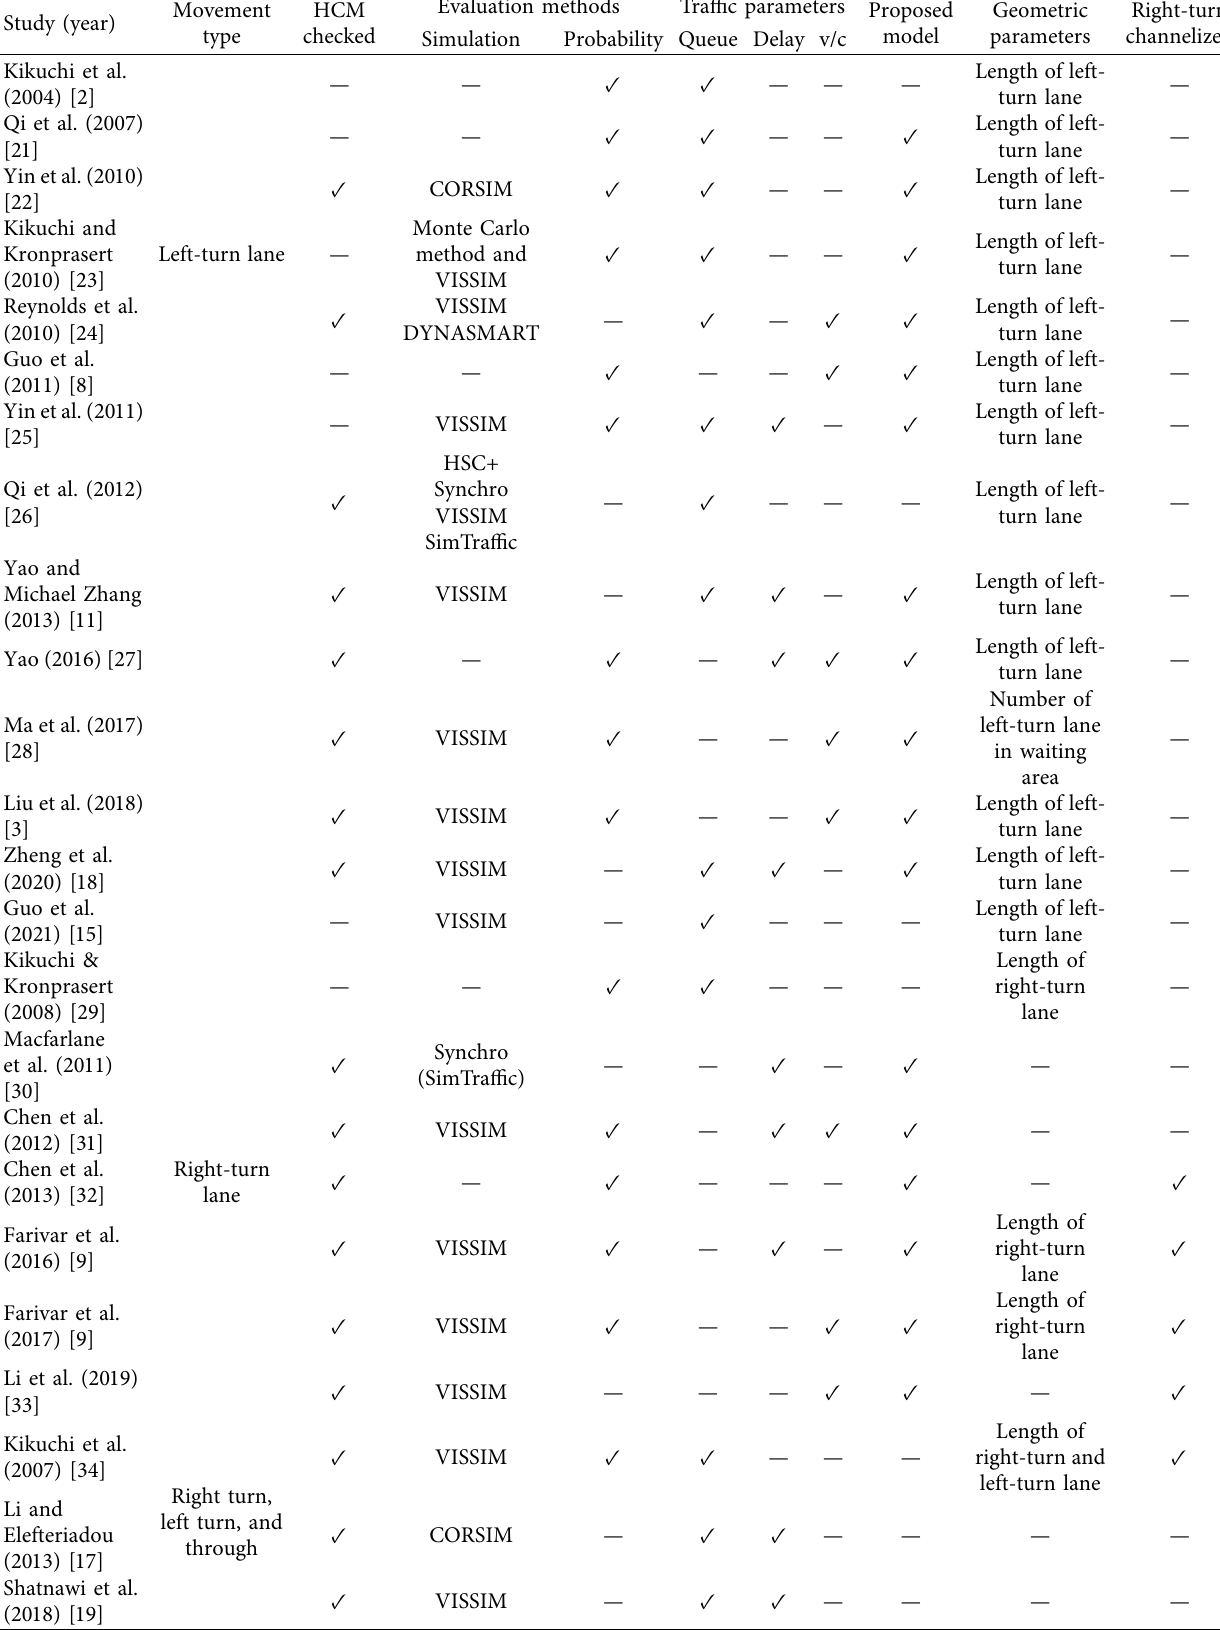
Table 1: Studies related to signalized